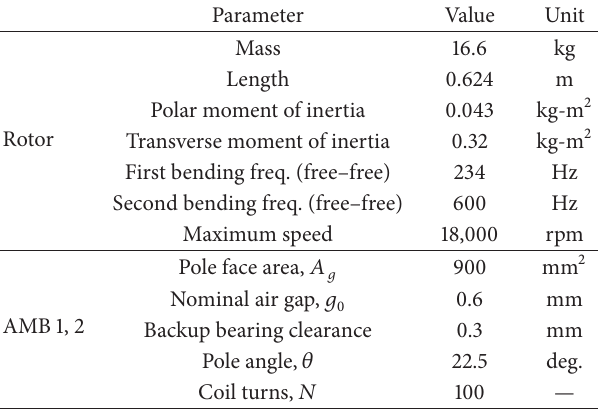
Table 1: Specifications of the controller test